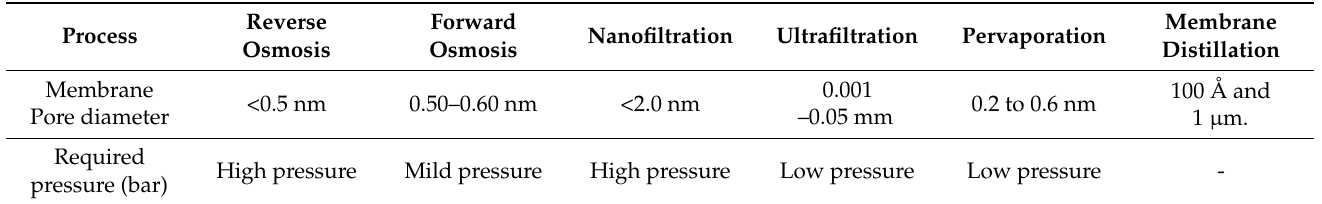
Table 1. Description of different desalination technologies with the required pressures and membrane pore size